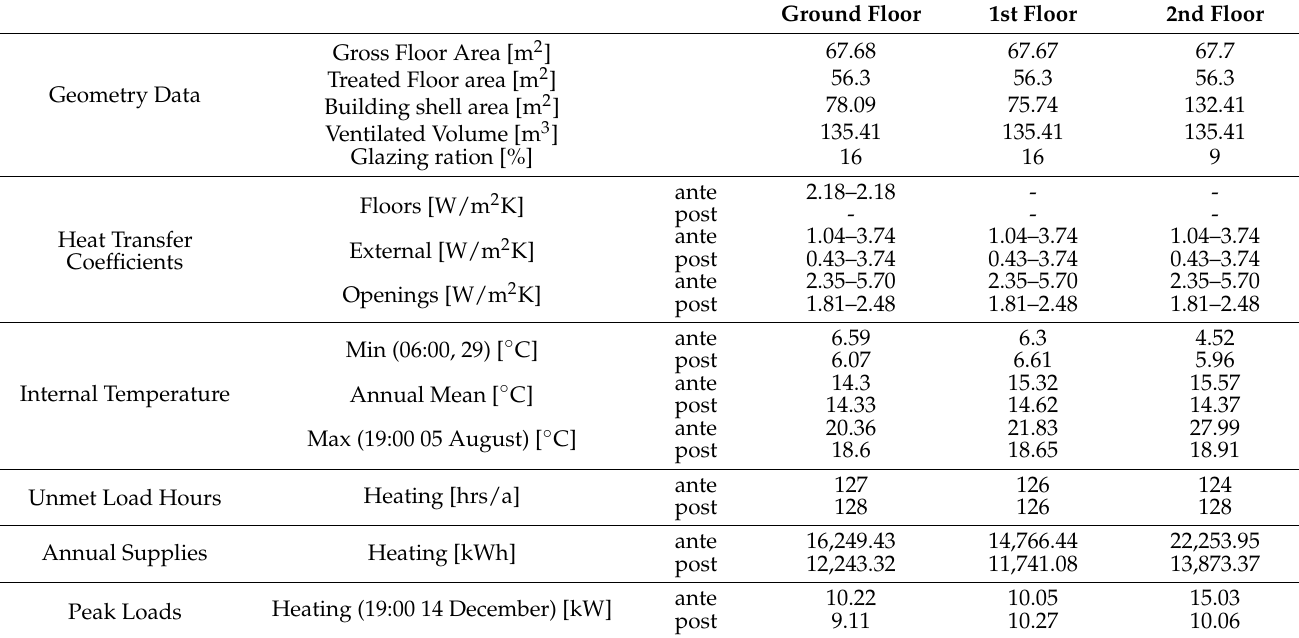
Table 2. Geometric characteristic of the analyzed apartment and simulation result ante and post ideal retrofit